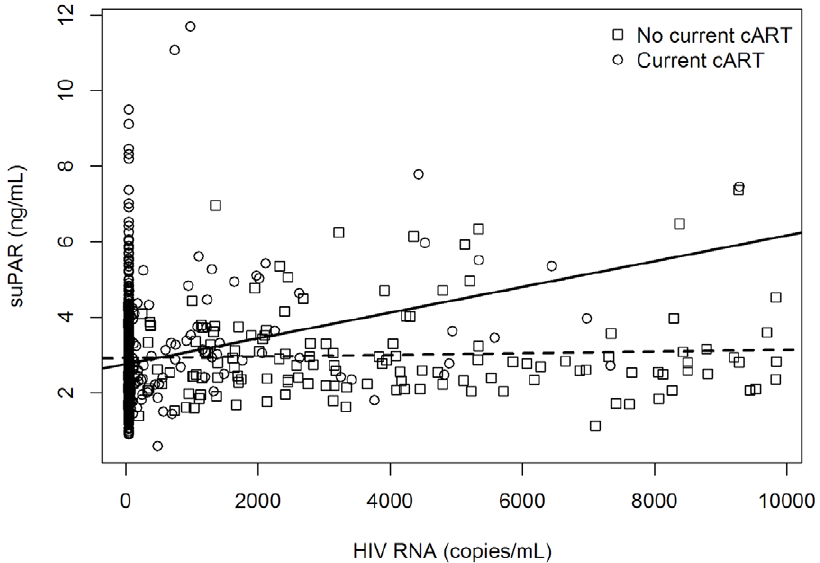
Figure 2. The association of suPAR and viral load according to treatment status. The figure represents a scatter plot of the association between suPAR and viral load. Circles represent cART-treated patients (N=838); boxes represent non cART-treated patients (N=152). The regression line for cART-treated patients is continuous; the regression line for non-cART treated patients is dashed. The lower level of detection of HIV RNA in this study was 39 copies/mL. Abbreviations: cART: Combination antiretroviral treatment; suPAR: soluble urokinase plasminogen activator receptor.